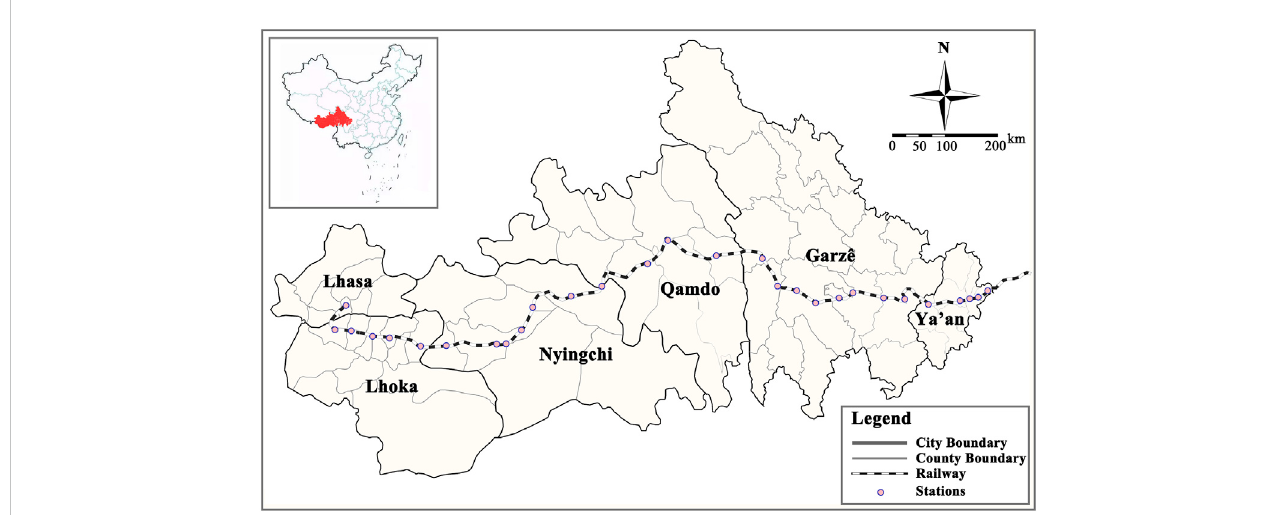
FIGURE 1 Sichuan-Tibet Railway and six cities (states) as study objects.